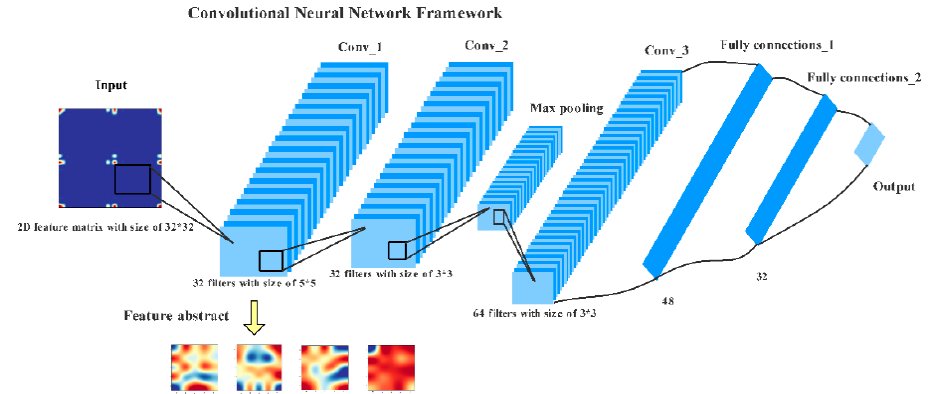
Figure 4. Example of CNN for material property prediction. Reprinted from [17] with permission from MDPI.